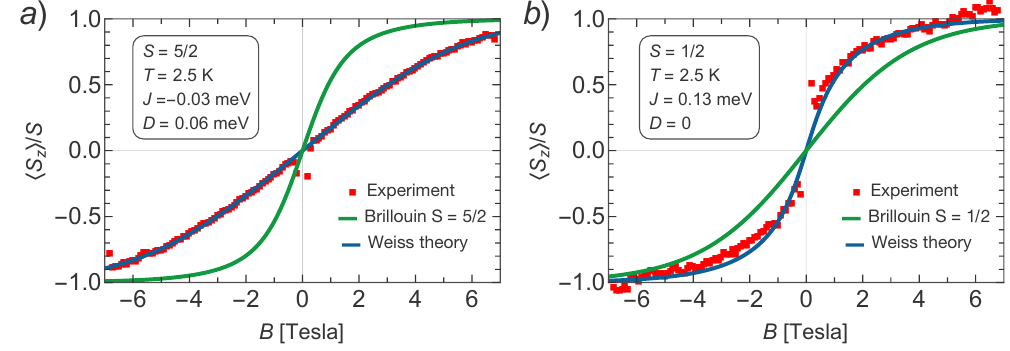
Figure 3. The best fit with the Weiss mean-field theory to the experimental data for ( a ) Mn–TCNQ and ( b ) Ni–TCNQ at normal beam incidence ( θ = 0 ◦ ) and the temperature T = 2.5K. The experimental data are shown in red squares, whereas the solution of the mean-field self-consistency equations is shown as the blue solid curve. For comparison, we also plot the Brillouin function for S = 5/2 in ( a ) and S = 1/2 in ( b ), showing that the shape of the measured magnetization versus B deviates substantially from the Brillouin function at this temperature.